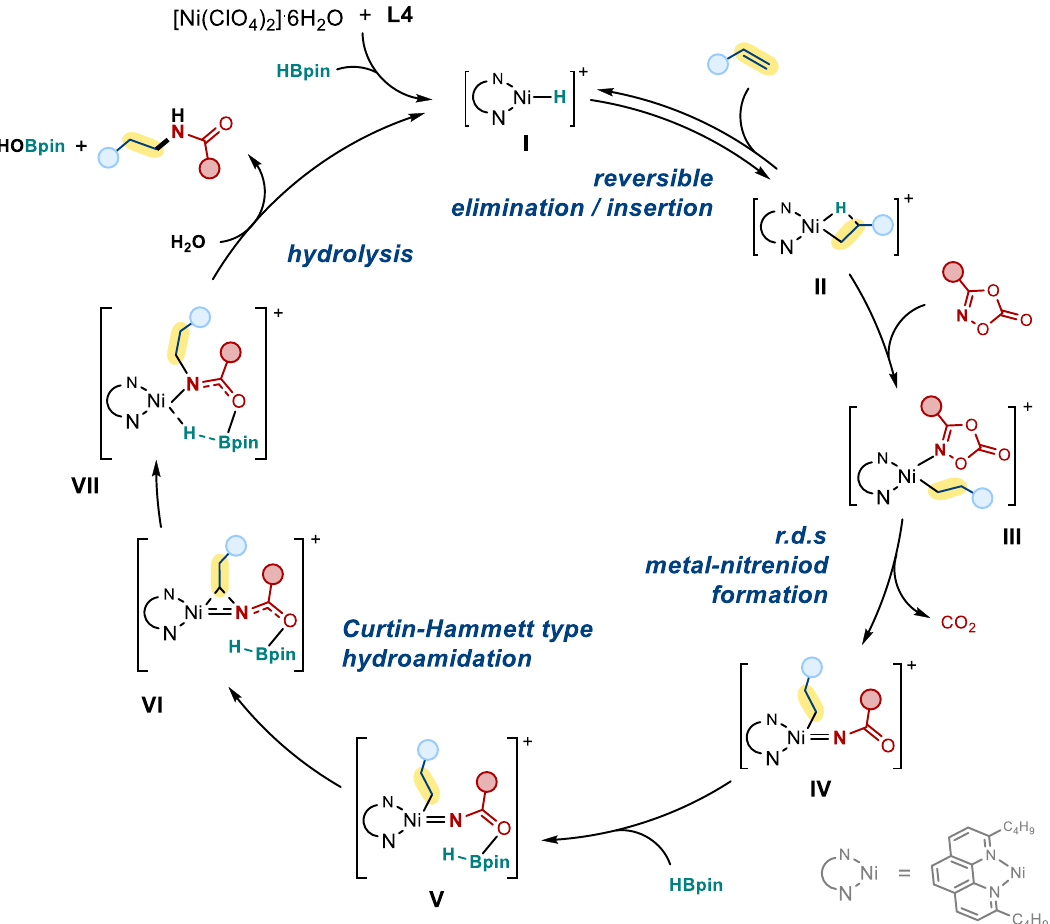
Fig. 10 Proposed mechanism for the NiH-catalyzed ligand enabled Curtin-Hammett type hydroamidation. Our proposed NiH-catalyzed ligand enabled Curtin-Hammett type hydroamidation